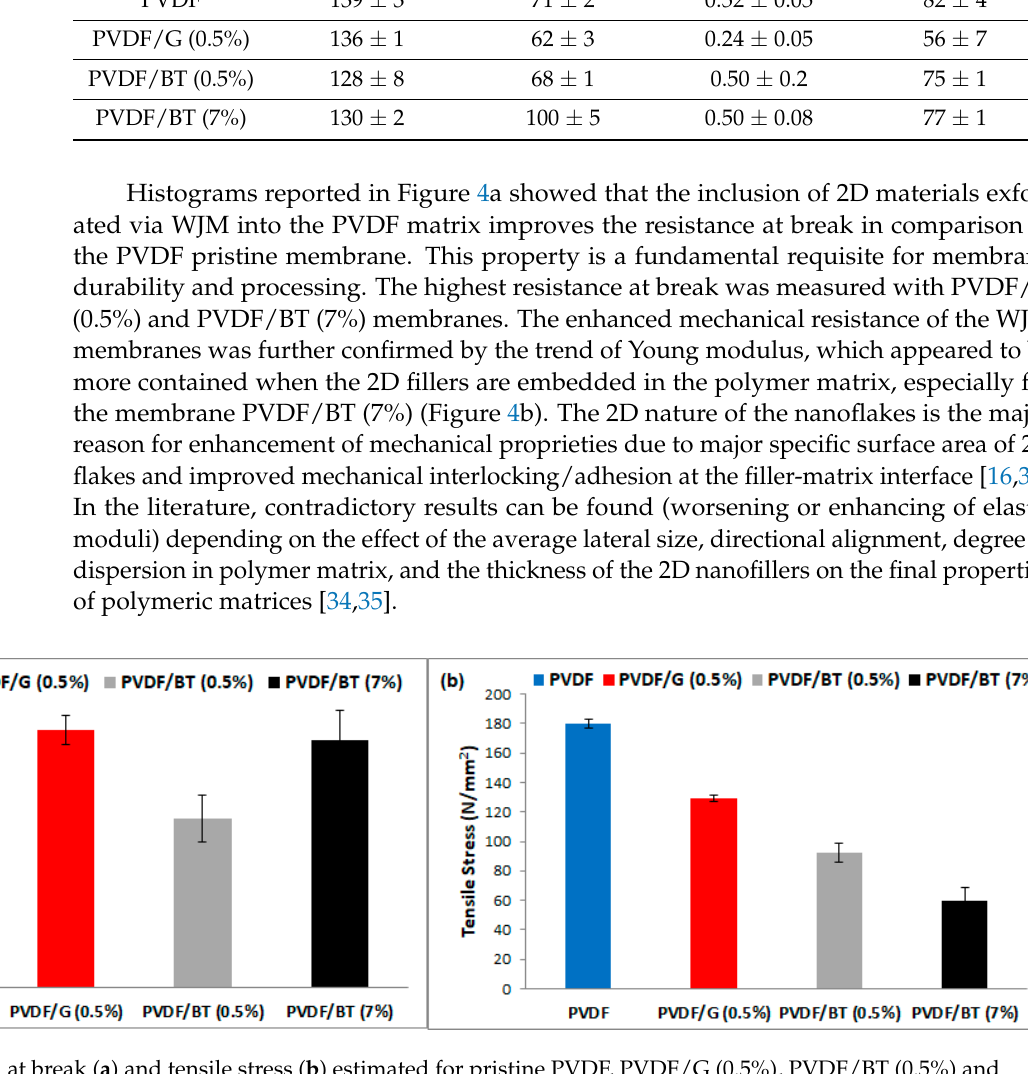
Figure 4. Elongation at break ( a ) and tensile stress ( b ) estimated for pristine PVDF, PVDF/G (0.5%), PVDF/BT (0.5%) and PVDF/BT (7%) membranes.